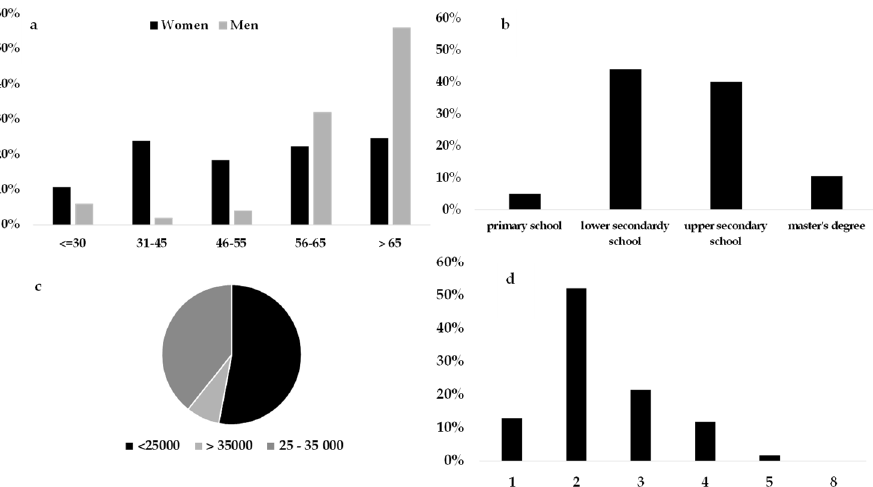
Figure 4. Sociodemographic characteristics of consumers belonging to the undecided cluster: ( a ) Gender and age groups proportion, ( b ) educational level, ( c ) yearly average income bracket, and ( d ) number of family components.